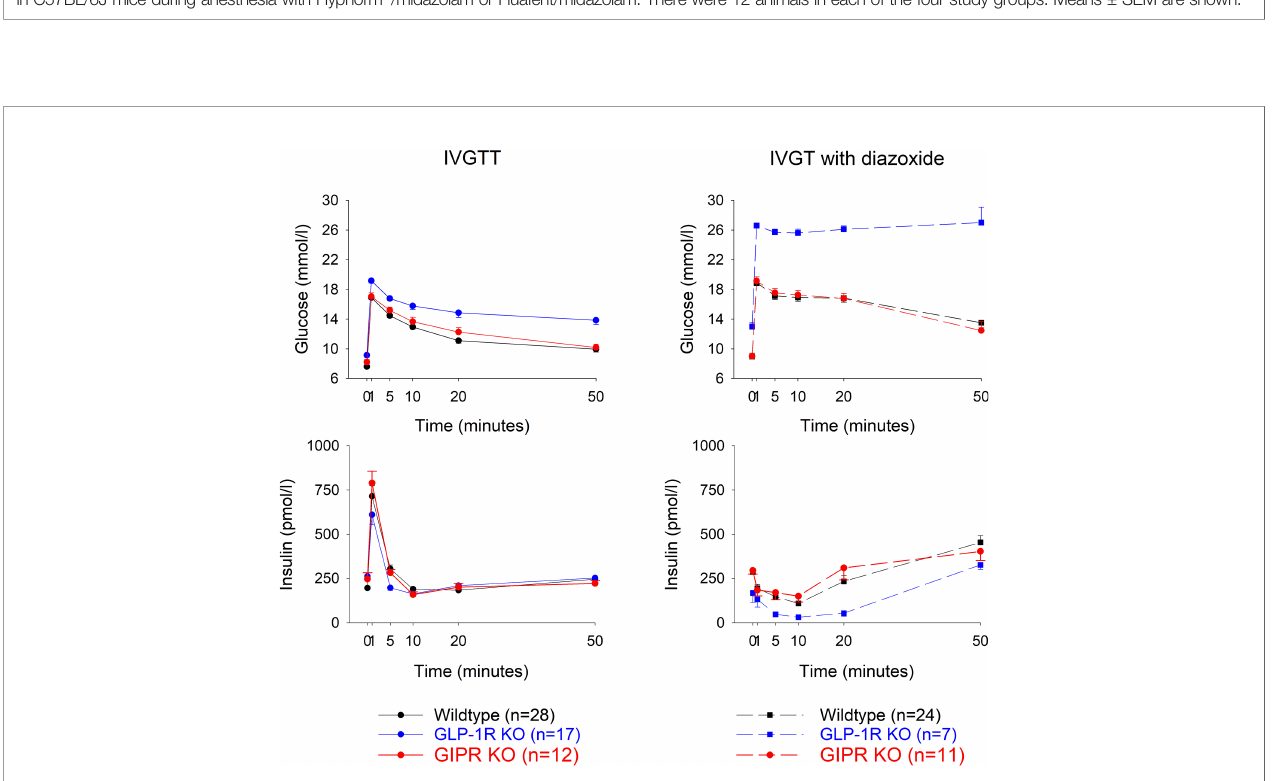
FIGURE 2 | Glucose and insulin levels after intravenous injection of glucose (0.35g/kg) with a subcutaneous administration of a vehicle (left panels) or diazoxide (25 mg/kg, right panels) in wildtype, GLP-1 receptor knockout or GIP receptor knockout mice. n indicates number of animals. Means ± SEM are